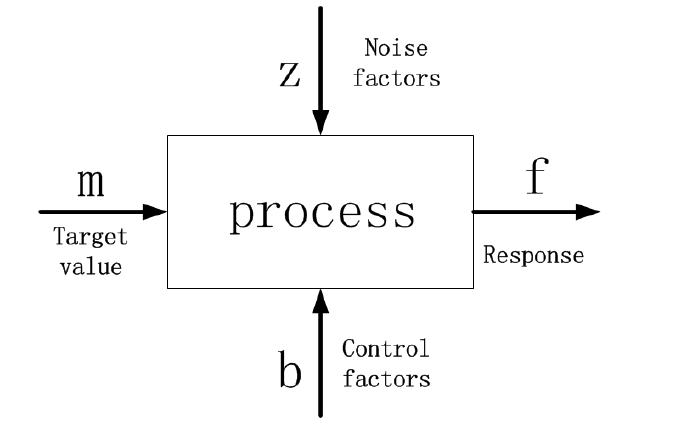
Figure 1. Robust Design.